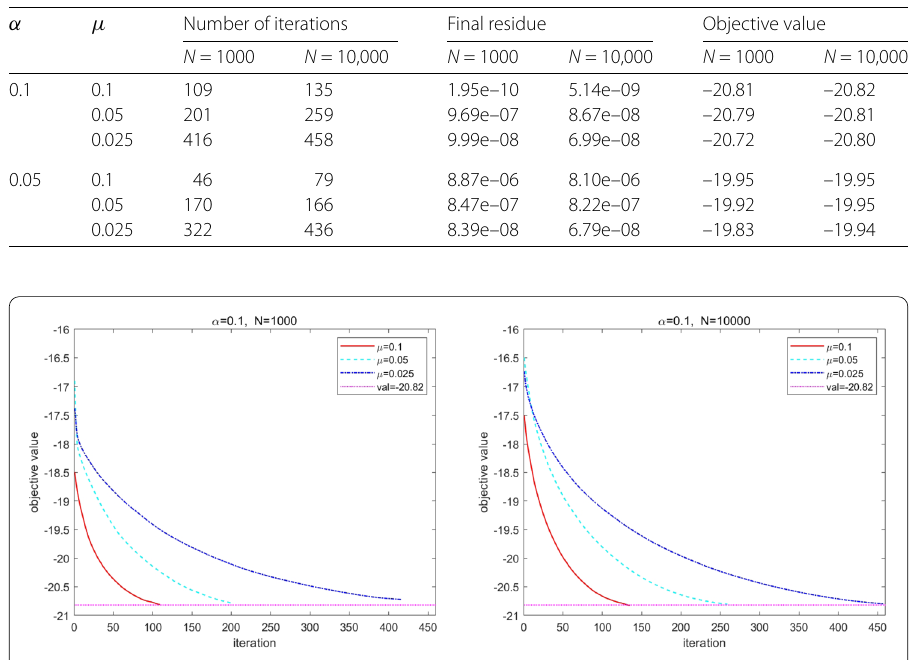
Figure 2 Performances of SCA algorithm based on the sigmoid function ψ ( z , μ ) for α = 0.1